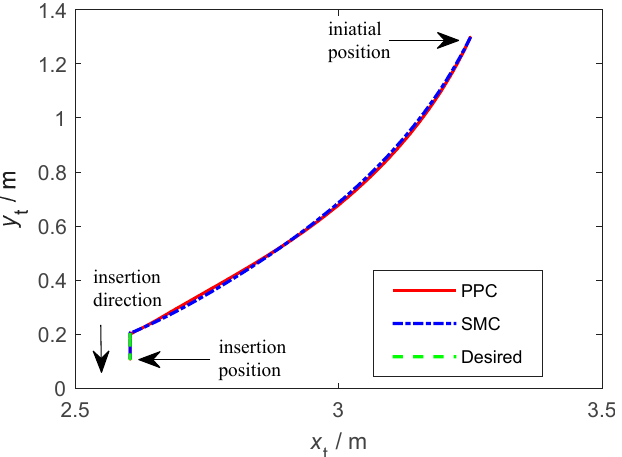
Figure 17. Space robot end X&Y-direction trajectory tracking curve of on-orbit extraction